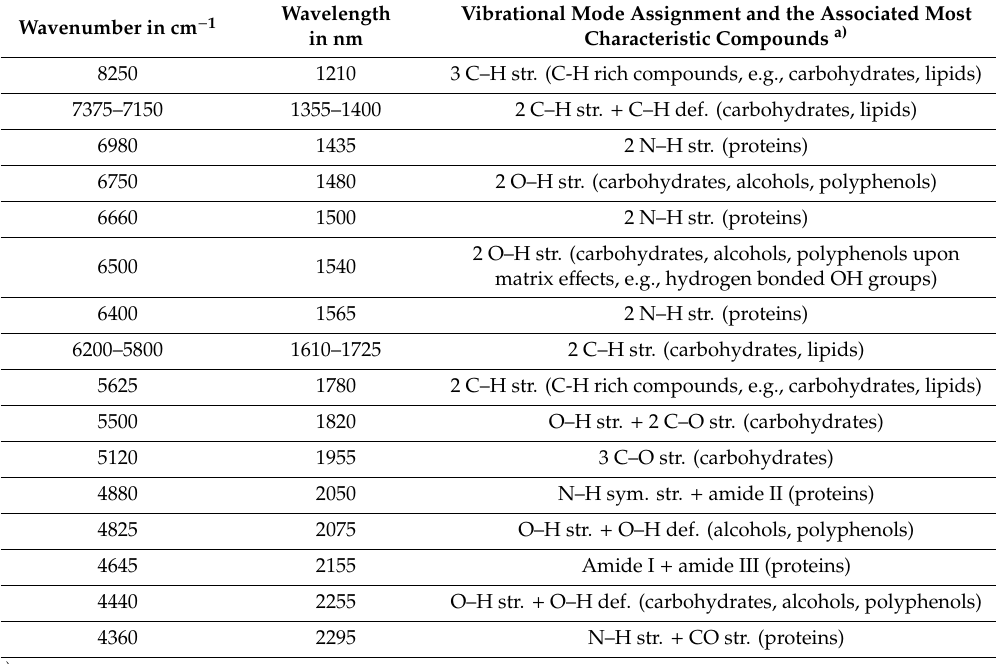
Table 1. Approximate positions of NIR bands that are meaningful for samples of biological origin (excluding water). In brackets provided are the exemplary chemical compounds for which the transitions are specific. The assignments adopted from literature